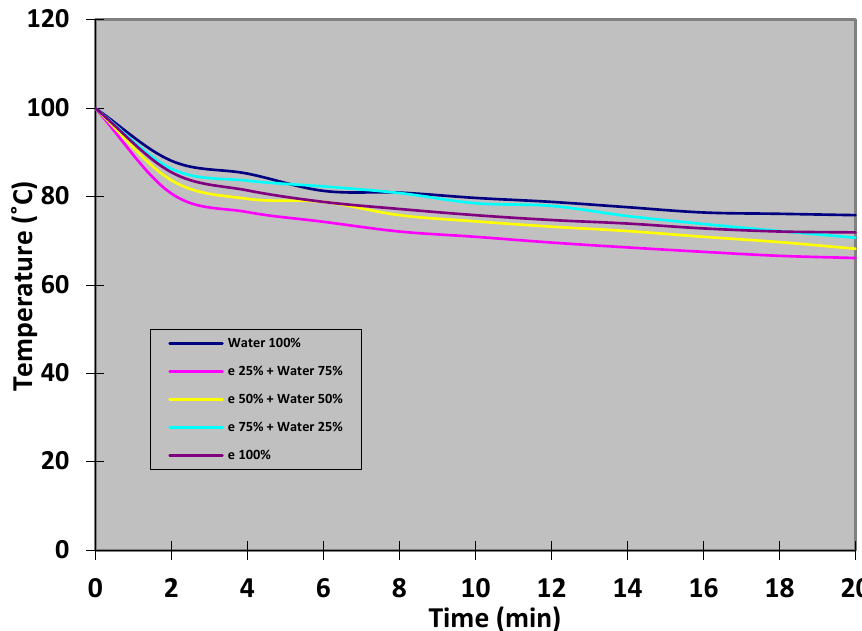
Figure 4. Surface temperature of the heater block for different liquid coolants at the 0.5 GPM flow rate.